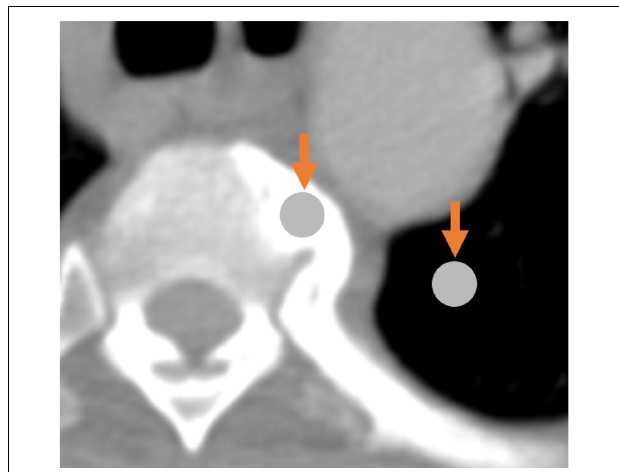
FIGURE 3 | Demonstration of the simultaneous contrast effect: although the two circles indicated by arrows are physically identical, the circle on the left appears darker relative to the (seemingly-brighter) circle on the